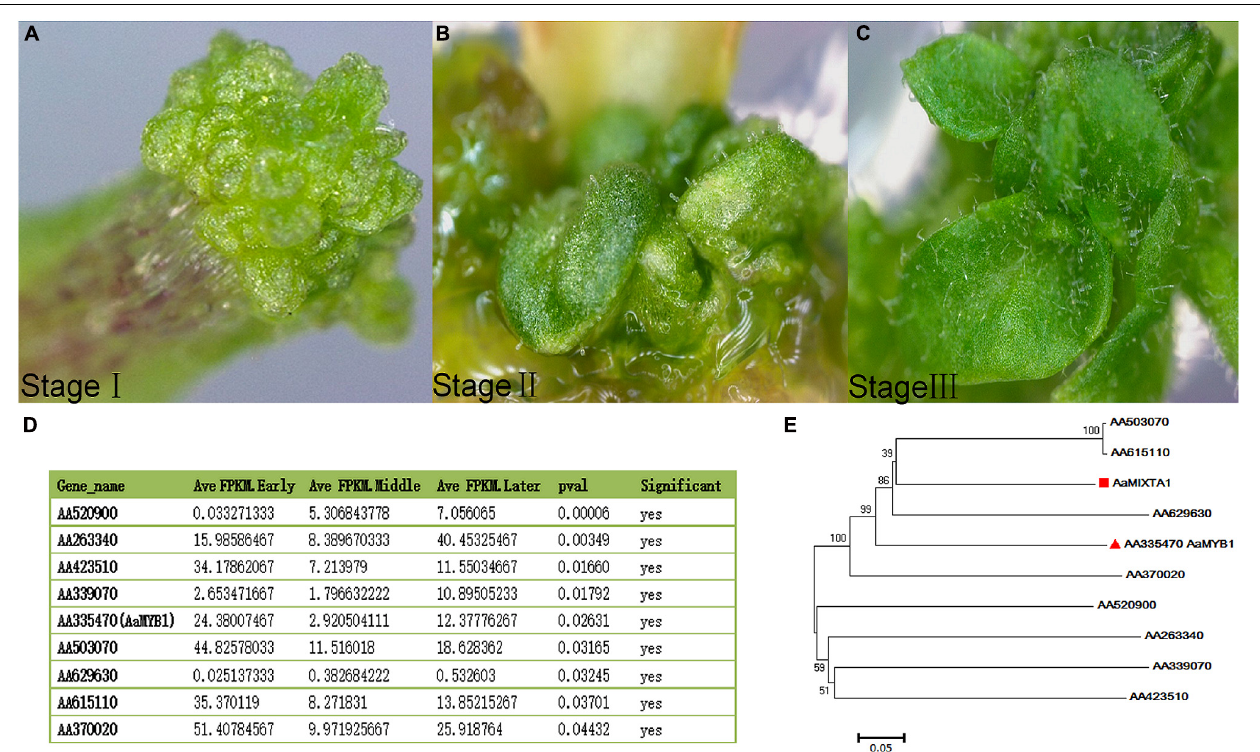
FIGURE 1 | Different developmental stages of A. annua calli. (A) After 2 weeks of culture on media, calli appeared on the leafstalk (explants). (B) Trichomes present on calli after 3 weeks of culture on media. (C) Additional trichomes present on calli after 4 weeks of culture on media. (D) Nine MYB transcription factors obtained from RNA-seq data across three stages, p < 0.05. One of these transcription factors is AaMYB61, which is a positive regulator of trichome development. (E) Phylogenetic tree showing that AaMIXTA1 and AA335470 (AaMYB1) are closely related, suggesting that AA503070, AA615110, and AA629630 may play roles in trichome